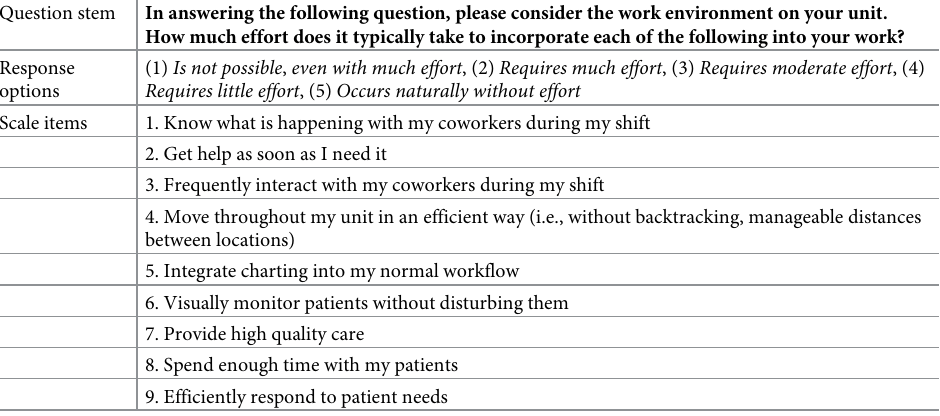
Table 8. Revised CARE scale survey instrument. Question